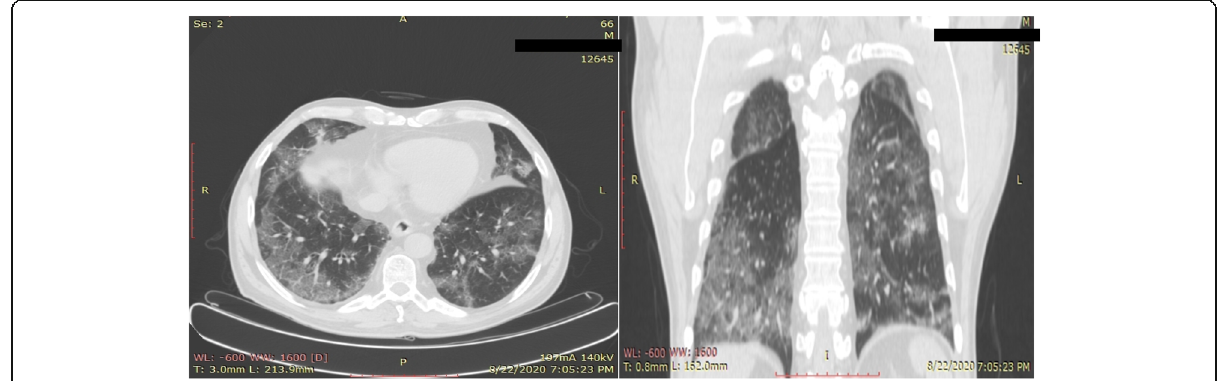
Fig. 3 Chest CT of a 66-year-old male patient showing bilateral ground glass pulmonary changes predominantly in peripheral distribution. The lung involvement was 50 – 75% and the CT severity index score was 4. The PCR test for COVID-19 was positive for this patient